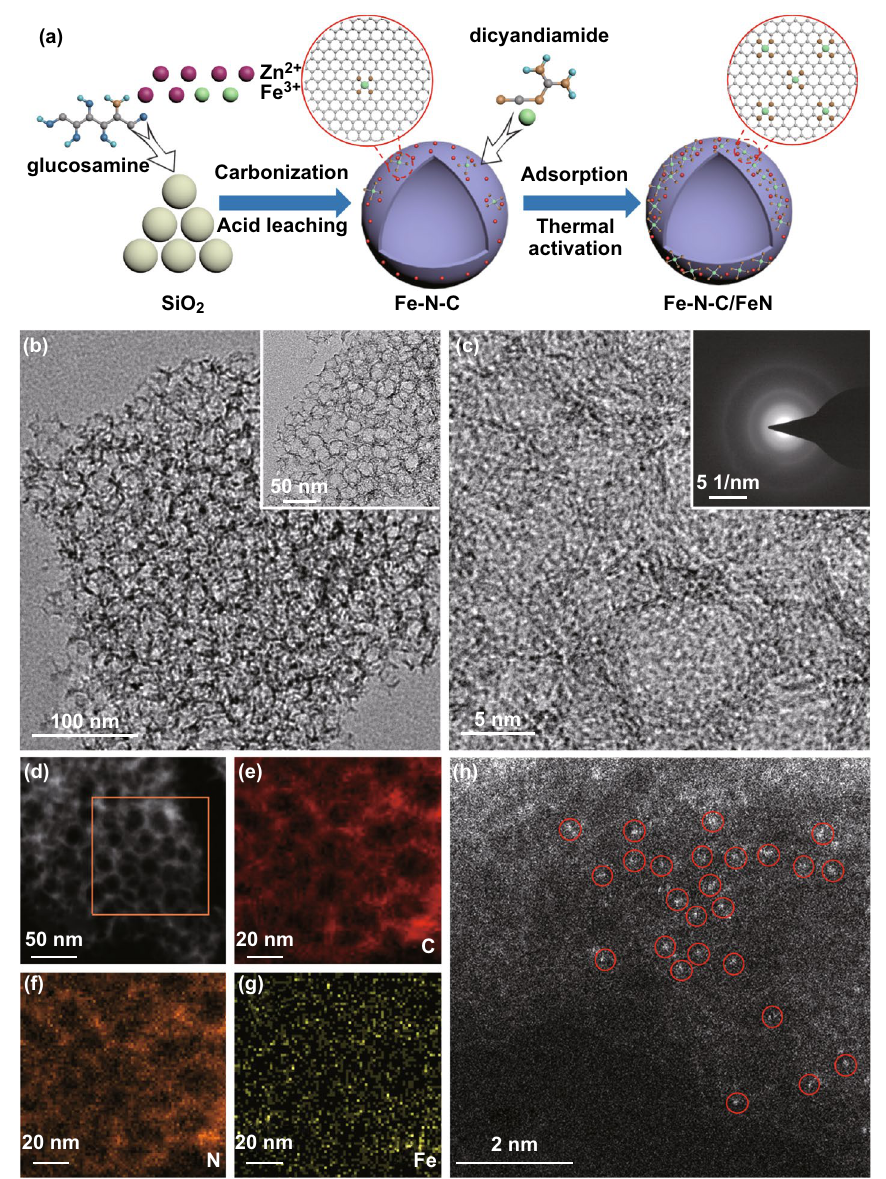
Fig. 1 a Schematic illustration of the synthesis route. b TEM and c HRTEM images of Fe–N–C/FeN. Inset in c : SAED pattern of Fe-N-C/FeN. d‑g HAADF-STEM and relative elemental mapping images. h AC-STEM image of